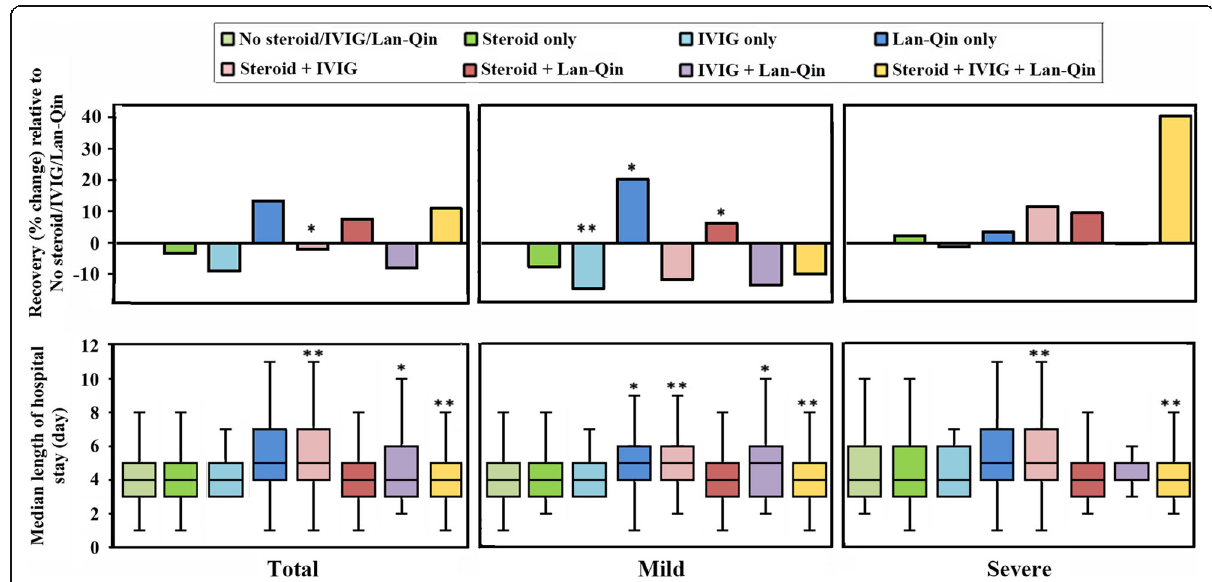
Fig. 2 The outcomes as relative recovery rates (upper panel) and median length of hospital stay (lower panel) of HFMD cases treated with steroids, IVIG, and Lan-Qin (2008 – 2016); * P < 0.05, ** P < 0.01 as compared to no steroid/IVIG/Lan-Qin group